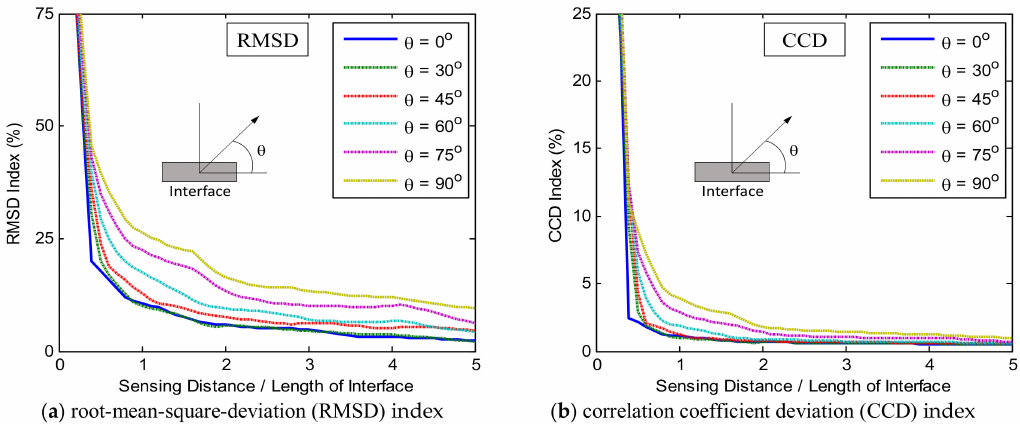
Figure 5. Relationships between damage-sensitive impedance features and sensing distance: Peak 1 in 10–20